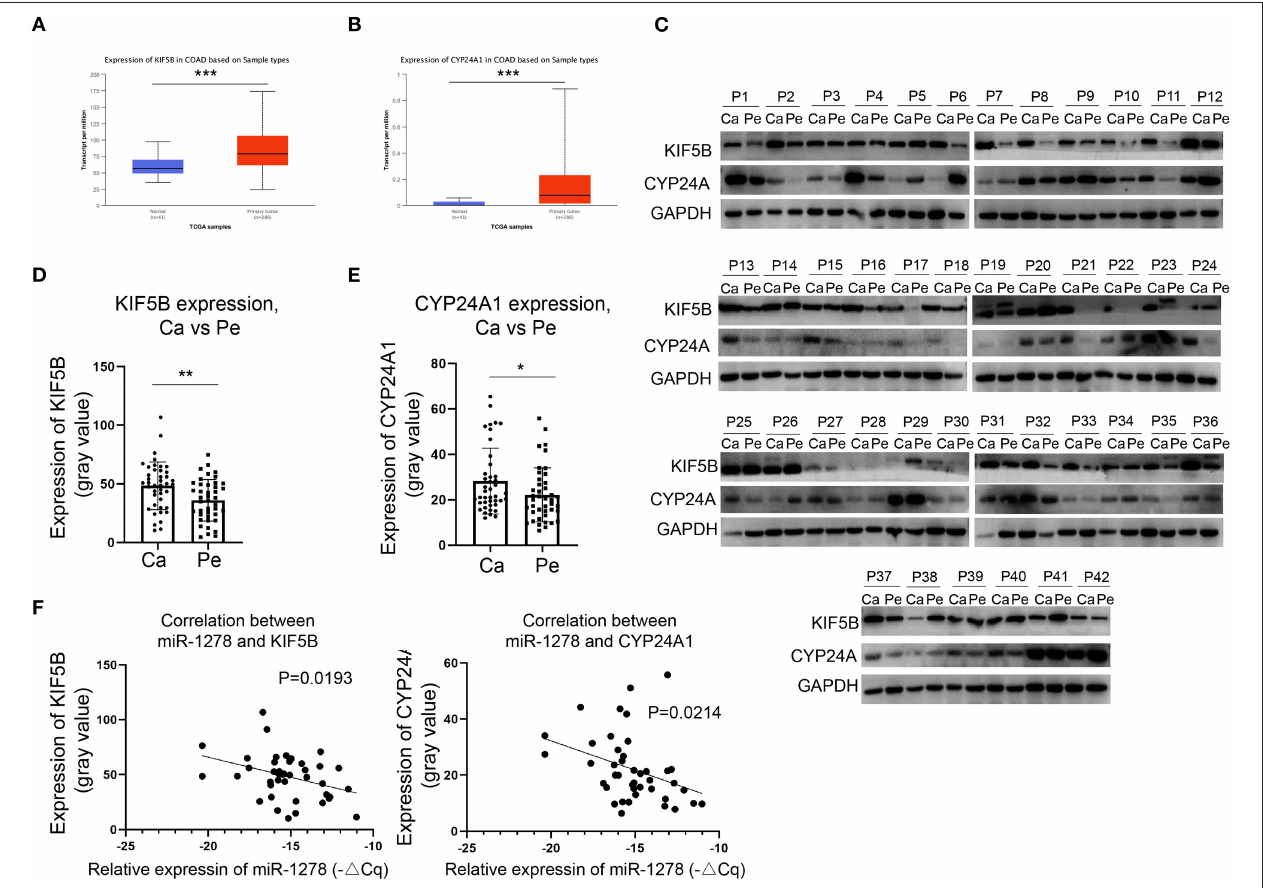
FIGURE 4 | KIF5B and CYP24A1 are overexpressed in CRC and negatively correlate with the expression of miR-1278. (A,B) The expression of KIF5B and CYP24A1 was measured in datasets of the TCGA COAD (colon adenocarcinoma) program. KIF5B and CYP24A1 were significantly upregulated in tumor samples compared to normal tissues. (C) The protein expression of KIF5B and CYP24A1 was determined by Western blotting in 42 pairs of CRC samples. (D) Compared to peritumoral tissues, KIF5B was significantly upregulated in cancer tissues. (E) Compared to peritumoral tissues, CYP24A1 was significantly upregulated in cancer tissues. (F) KIF5B or CYP24A1 expression and miR-1278 showed a negative correlation in CRC cancer tissues. Ca, cancer; Pe, peritumoral; P, patient; * P < 0.05, ** P <